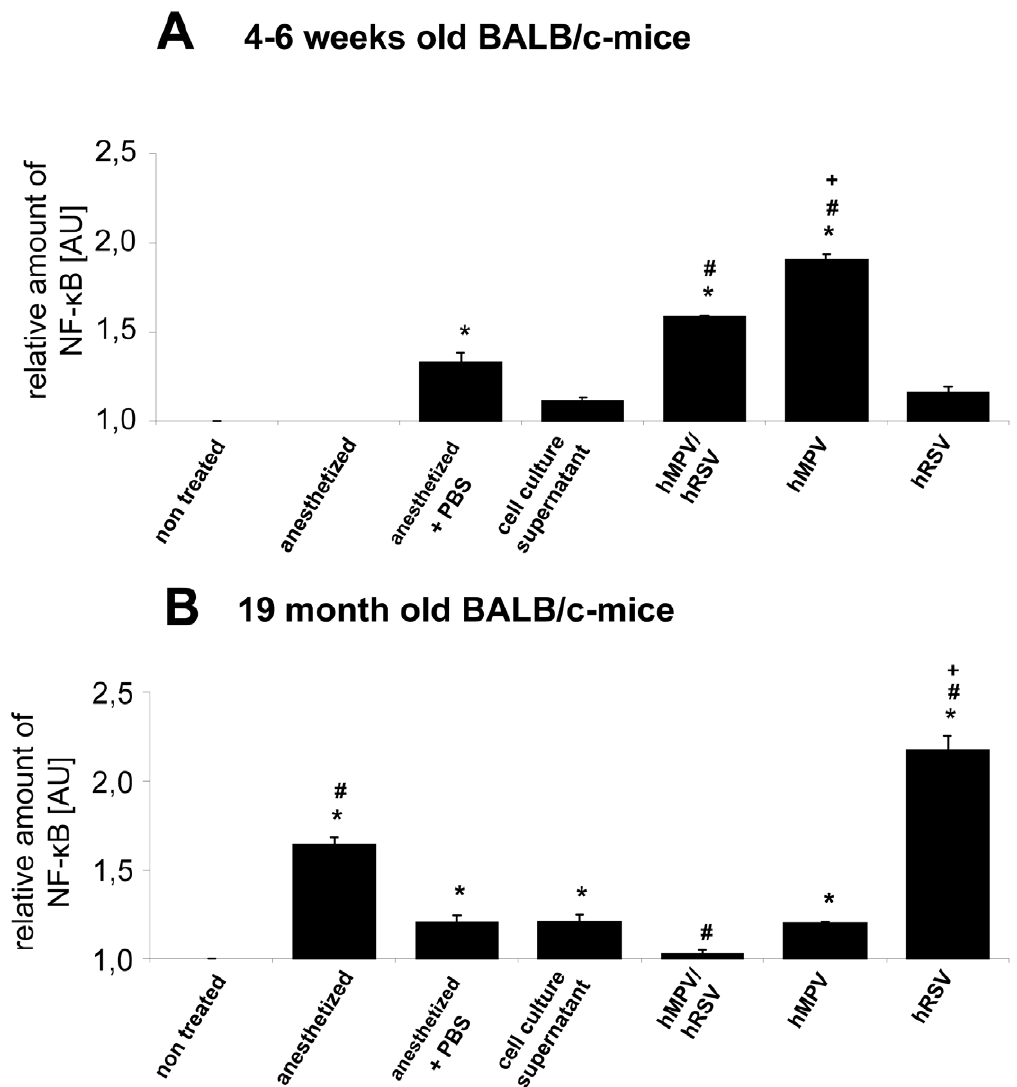
Figure 5. NF- k B expression in the lung after infection. Amount of NF- k B in the lungs of 4–6 weeks (A) und 19 months (B) old BALB/c mice after infection with RSV, HMPV or double infection: 4–6 weeks and 19 months old BALB/c-mice were infected with 2 6 10 7 geq RSV, or HMPV, or co-infected with 1 6 10 7 geq of each virus. Untreated animals, animals anesthetized and treated with cell culture supernatant or PBS or only anesthetized served as controls. Mice were killed by cervical dislocation and the lungs were removed, homogenised. The amount of NF- k B was determined by ELISA. Values were standardized referring to non treated controls (n=3–5, values are shown as mean 6 standard deviation). * significantly different to untreated animals (p , 0.05). # signifcantly different to cell culture infected animals (p , 0.05). + significantly different to hMPV and hMPV/RSV- infected animals (p , 0.05).